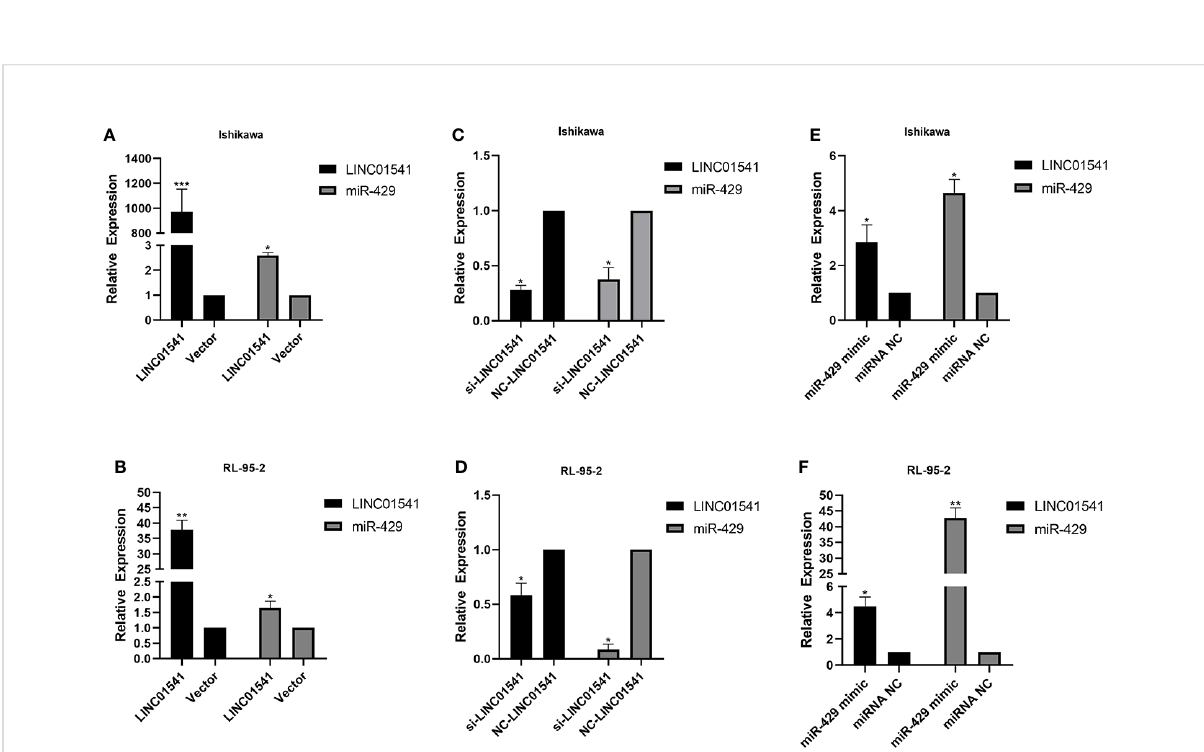
FIGURE 4 LINC01541 and miR-429 were transfected to measure expression. (A, B) After forced overexpression of LINC01541, the expression of LINC01541 and miR-429 were up-regulated in Ishikawa and RL95-2 cells. (C, D) When cells were transfected with LINC01541 siRNA, the expression of LINC01541 and miR-429 was down-regulated. (E, F) After both cells were treated with miR-429 mimics, the expression of LINC01541 and miR- 429 was up-regulated. (* P <0.05; ** P <0.01; *** P